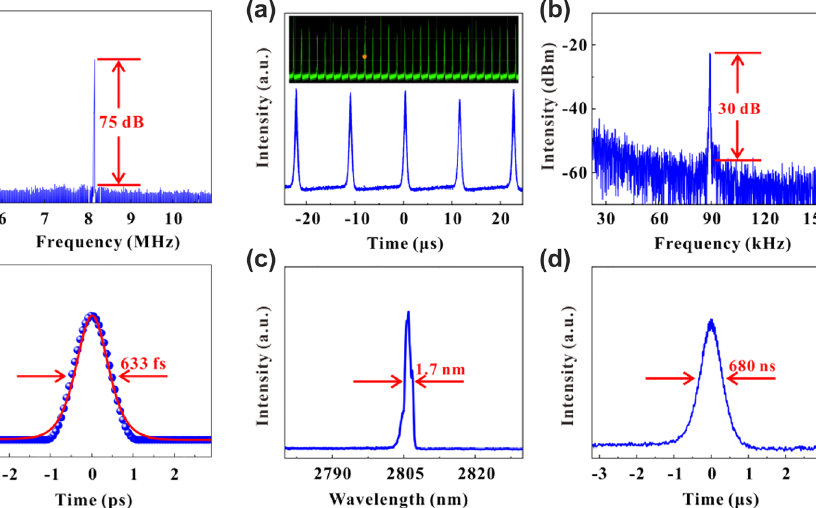
Figure 9: Experimental results of the 2.8 µm Q-switched laser. (a) The pulse sequence displayed on the oscilloscope. (b) The RF spectrum. (c) Spectral diagram. (d) Single-pulse